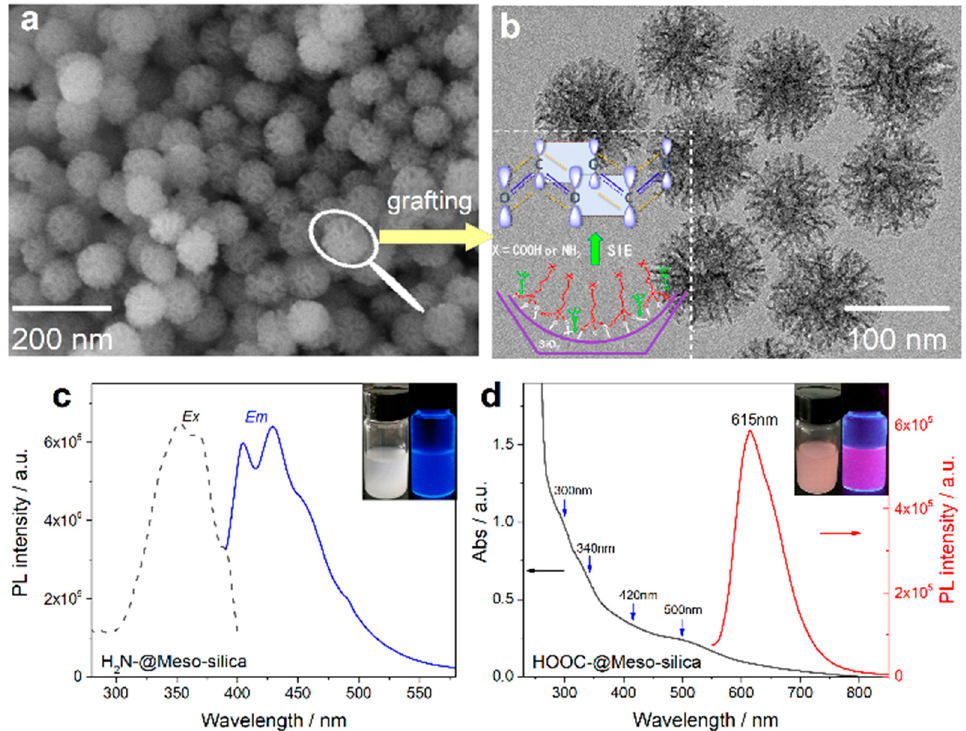
Figure 16. Ligand assembly in the mesoporous silica nanoparticles (MSNs) free of metals and their tunable luminescent properties. Scanning electron microscopy (SEM) ( a ) and TEM ( b ) images of as-synthesized fluorescent mesoporous silica nanoparticles. The inset shows the assembly of amino and carbonyl groups in the confined nanopores. ( c ) Excitation and emission spectra of aminopropyl-functionalized MSNs. ( d ) Absorption and emission spectra of propylsuccinic-functionalized MSNs. Reprinted with permission from Ref. [43]. Copyright (2019) Springer Nature.